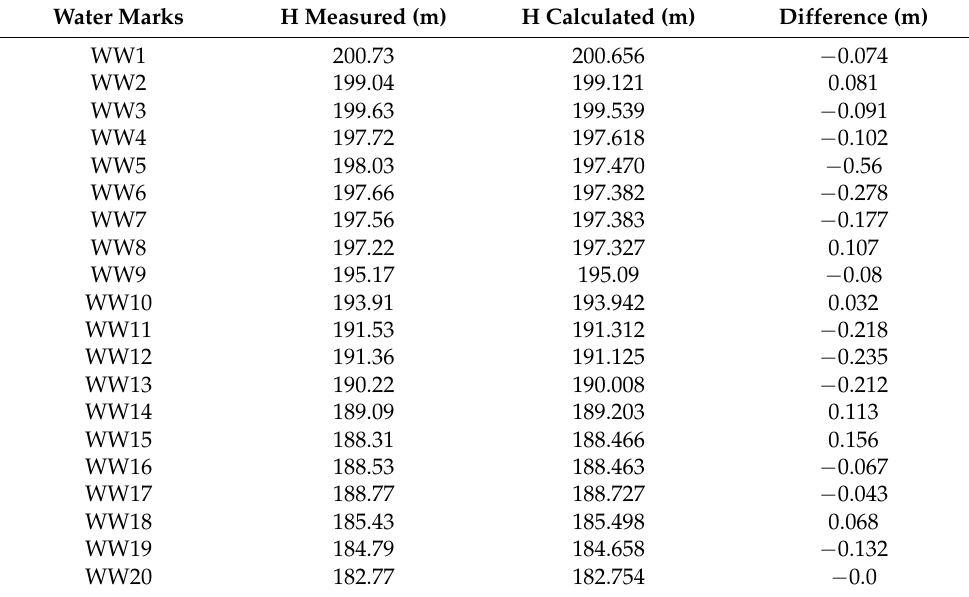
Figure 12. 2D simulation of the flood on the Lusatian Neisse in 2010. The flood wave peaked in the city of Zgorzelec, while it descended in the village of Radomierzyce, and the reservoir became empty. Table 3. Comparison between the measured and calculated water levels (for location, see Figure